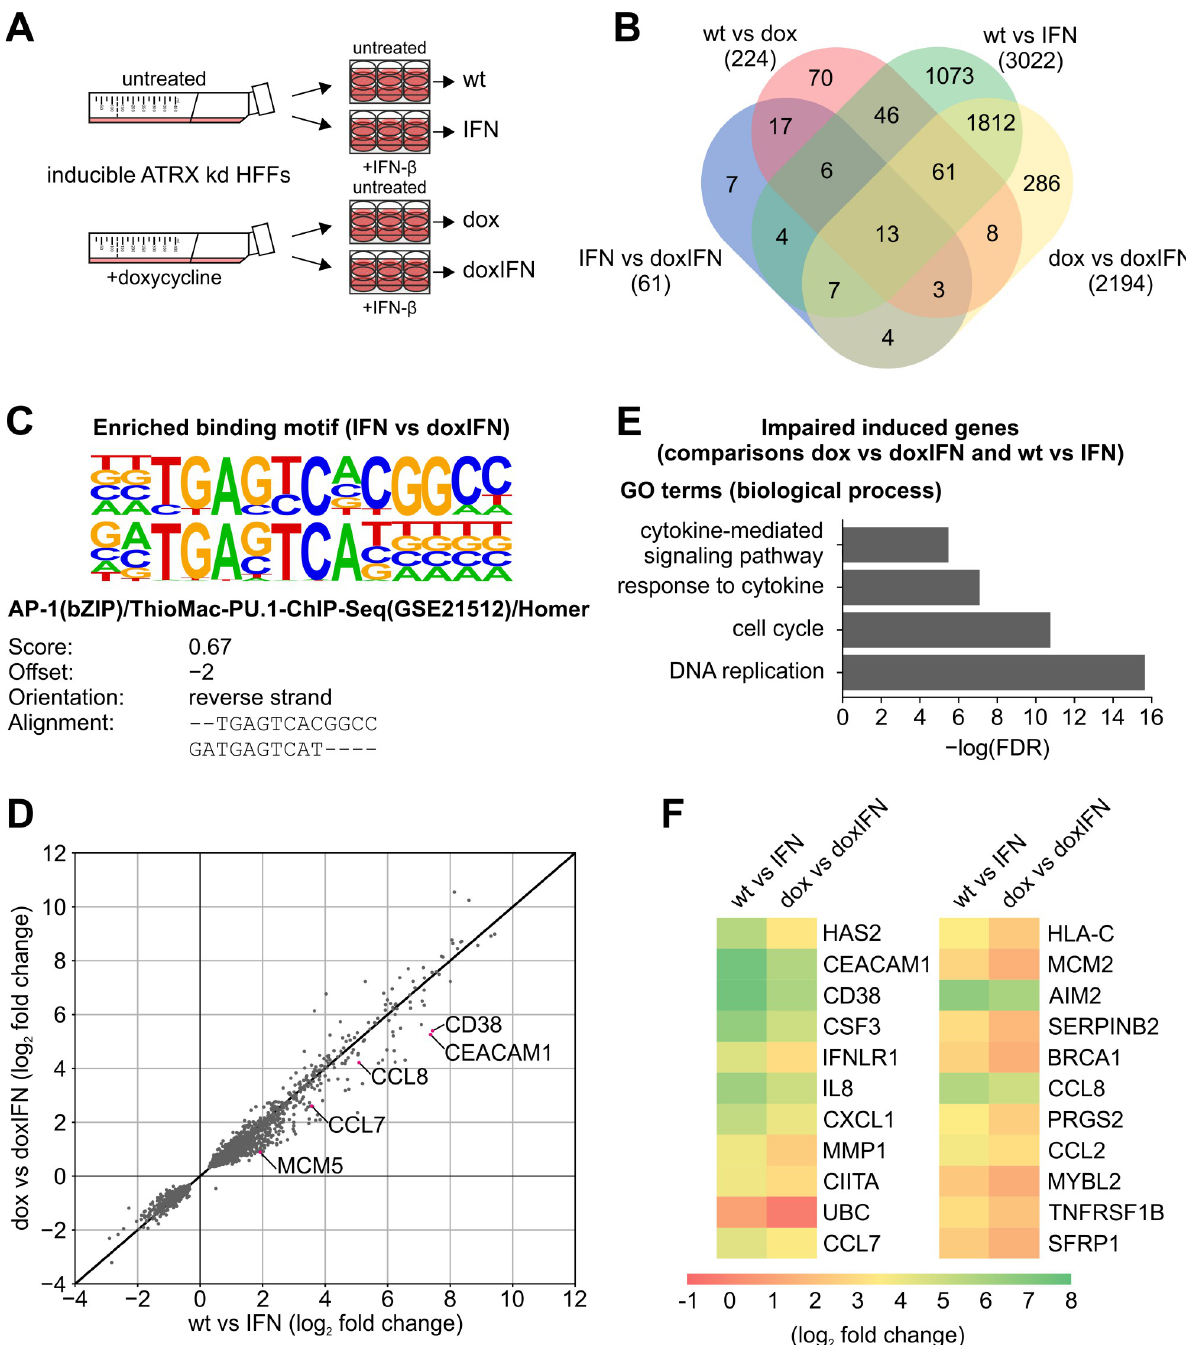
Fig 6. RNA-seq analysis of doxycycline-inducible ATRX knockdown HFFs stimulated with IFN- β . (A) Schematic representation of the experiment. Doxycycline-inducible ATRX knockdown (ATRX kd) HFFs were either treated with 500 ng/ml doxycycline (dox) for 14 days (d) or left untreated as a control, followed by stimulation with IFN- β (3.28 × 10 3 U/ml) for 24 h. Subsequently, total RNAs were prepared and subjected to RNA-seq. Samples were divided in four groups of triplicates (untreated: wt; only IFN- β -treated: IFN; only dox-treated: dox; dox- and IFN- β -treated: doxIFN). (B) Venn-diagram of pairwise comparisons of the four groups. Differentially expressed genes were filtered to an adjusted p-value < 0.01. The following online tool was used: http://bioinformatics.psb.ugent.be/webtools/Venn/ (accessed 13 Sep 2021). (C) Homer de novo motif analysis of promoter regions of the differentially expressed genes from the comparison dox vs doxIFN. The top motif (p-value of 10 − 14 ) is shown (top) aligned with one of the matched known motifs (bottom). (D) Scatter plot of log 2 fold changes from the comparison of dox vs doxIFN and wt vs IFN for every gene (n = 1893) with an adjusted p-value < 0.01. (E) Gene ontology (GO) terms of the category biological process for 85 corresponding proteins out of the top 100 hits with reduced log 2 fold changes in dox vs doxIFN compared to wt vs IFN; FDR: false discovery rate. (F) Heat map of proteins belonging to the GO terms response to cytokine (GO:0034097) and cytokine-mediated signaling pathway (GO:0019221). https://doi.org/10.1371/journal.ppat.1010748.g006 PLOS Pathogens| https://doi.org/10.1371/journal.ppat.1010748 August 8,